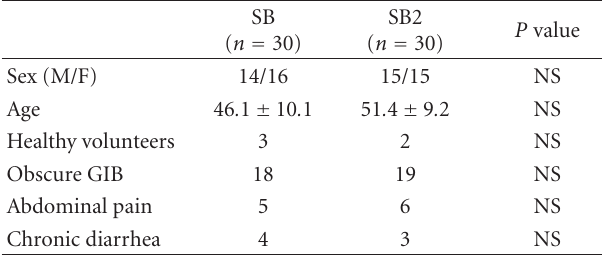
Table 1: Baseline characteristics and indications for wireless capsule endoscopy.